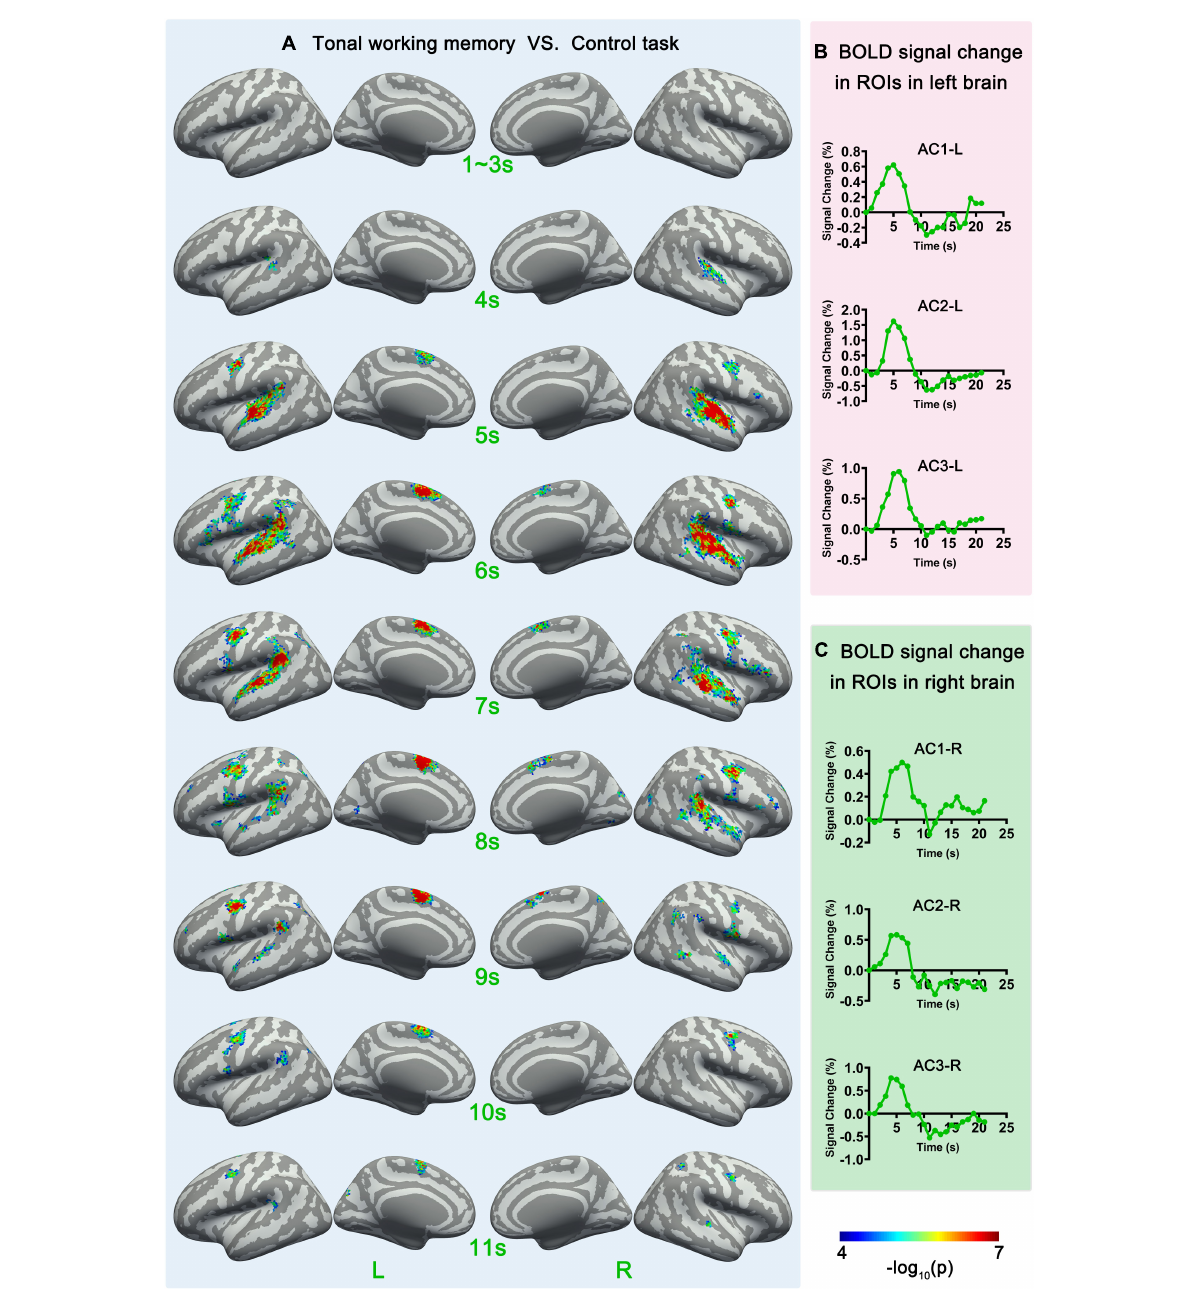
FIGURE3 Sf-MVPA analysis results of 1–11 s and BOLD curves of 6 ROIs. (A) The sf-MVPA results of 1–11 s of tonal working memory vs. control task. (B) Average BOLD curves of 3 ROIs in the left hemisphere. (C) Average BOLD curves of 3 ROIs in the right hemisphere. AC, auditory